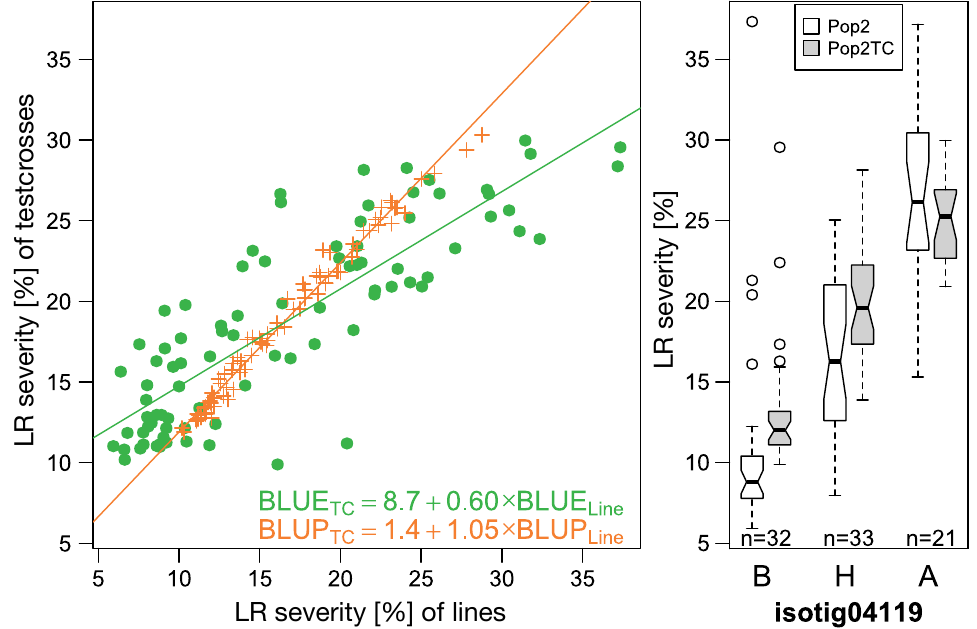
Figure 9. Correlation of line (P2) and testcrosses performance (P2TC) of best linear unbiased estima- tors (BLUEs) and predictors (BLUPs) for leaf rust severity ( left ) and boxplots for the most significant marker associated with LR in this populations ( right